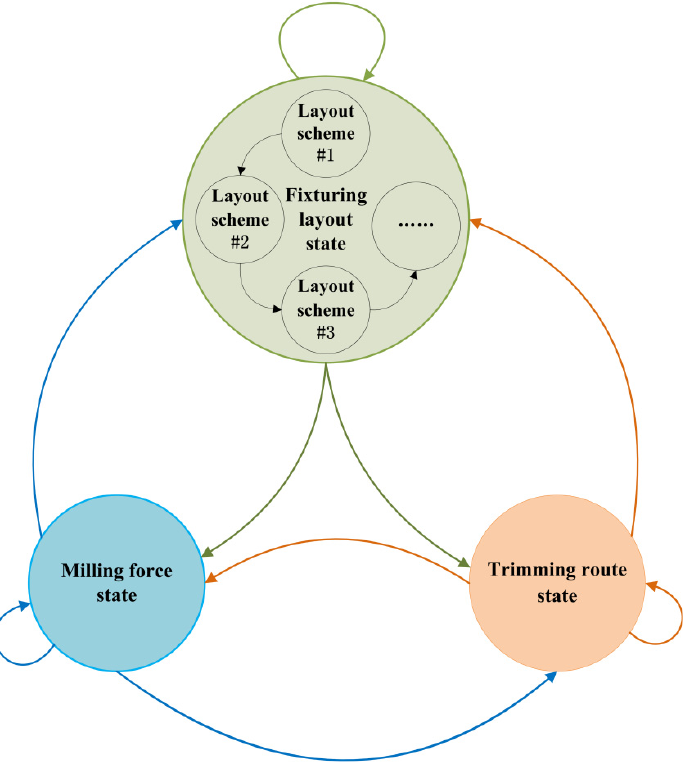
Figure 3. Interaction dynamics state space of the fixturing system based on hidden Markov model. Given a 3D free-form surface part with the trimming contours, the layout optimization problem of locators can be formulated